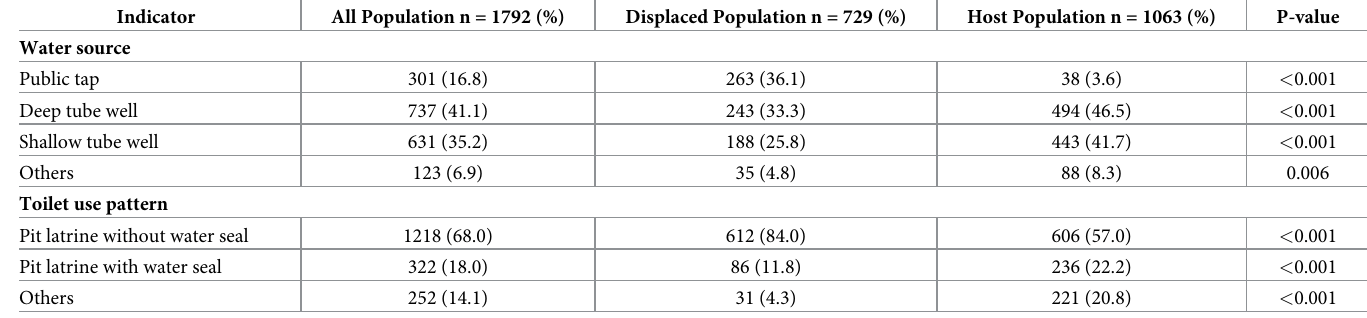
Table 4. Water sources for household consumption of patients reporting to DTCs � , April-December 2018, Cox’s Bazar, Bangladesh.